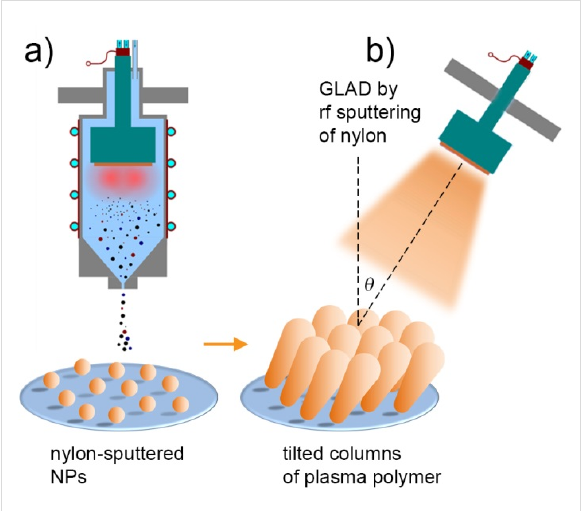
Figure 15: Scheme of GLAD: a) preseeding of substrates with nylon- sputtered NPs produced by GAS; b) GLAD of nylon-sputtered plasma polymer over the preseeded